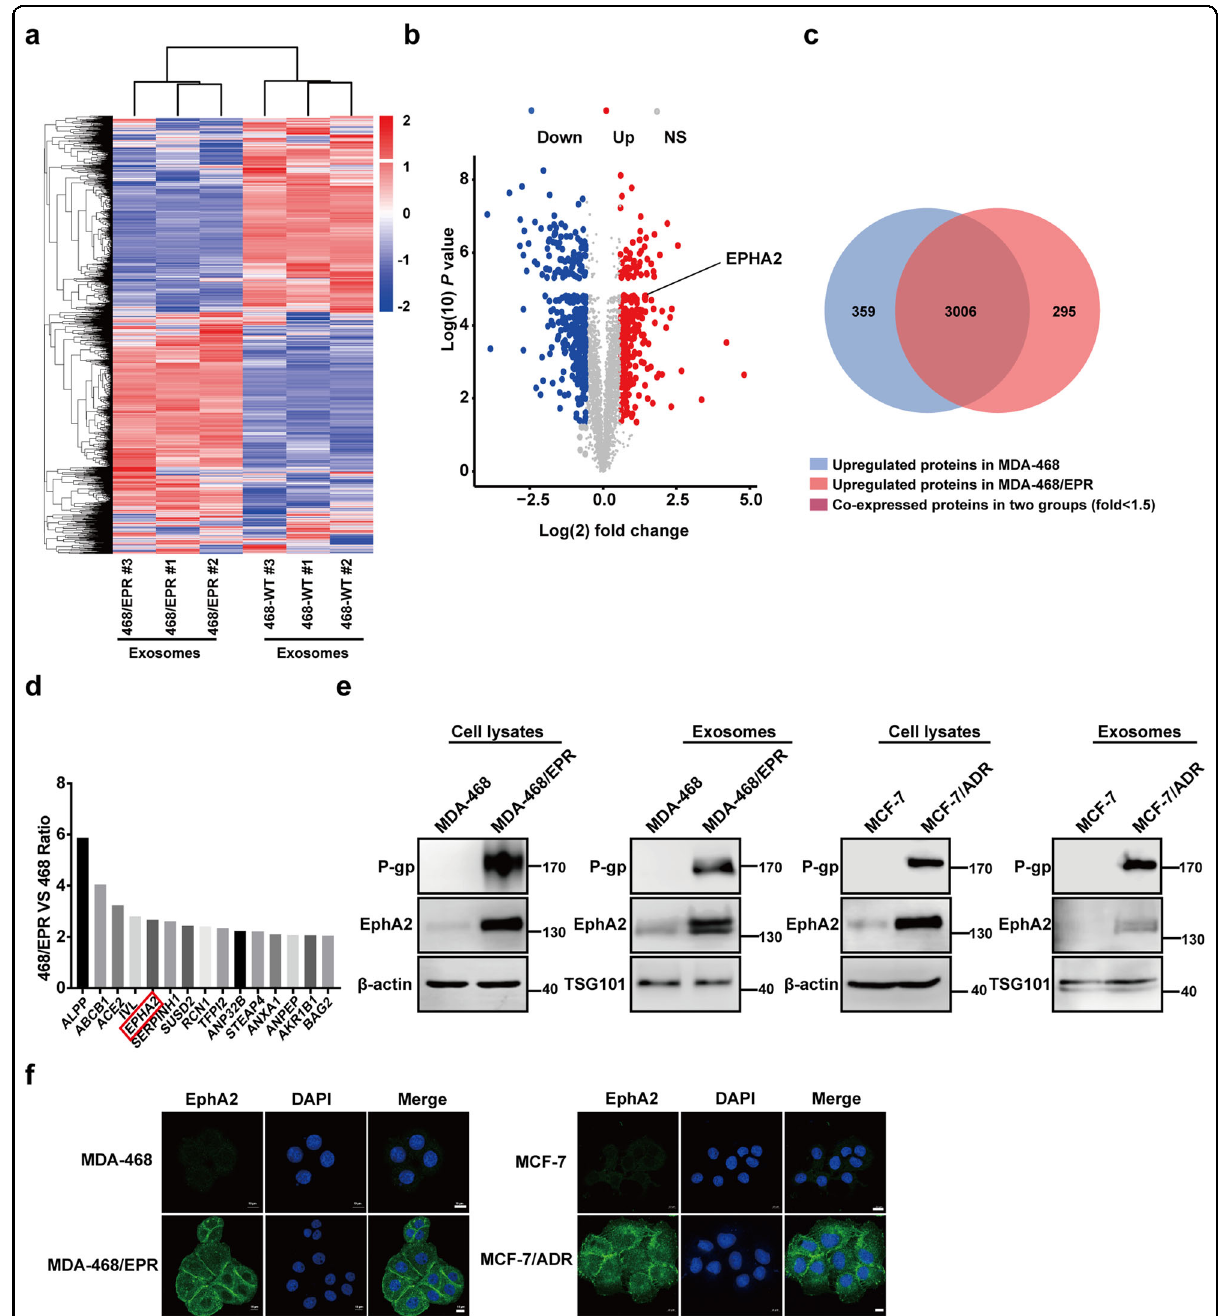
Fig. 2 EphA2 protein is enriched in exosomes derived from drug-resistant cells. a Heat map of exosomal proteins differentially expressed in MDA-MB-468 and MDA-MB-468/EPR cells. Exosomes were isolated from drug-resistant breast cancer cells and their parental cells, and then a TMT- based quantitative proteomic method was performed to identify differentially expressed proteins in two kinds of exosomes. b Volcano map of exosomal proteins differentially expressed in MDA-MB-468 and MDA-MB-468/EPR cells. Blue and red dots represent the proteins signi fi cantly upregulated in exosomes from MDA-MB-468 and MDA-MB-468/EPR cells. c The Venn diagram of different exosomal proteins in MDA-MB-468 cells and MDA-MB-468/EPR cells. d Fifteen proteins were identi fi ed by using a strict cutoff (fold change >2.00, score >100). e The expression of EphA2, ABCB1 (encode P-glycoprotein) in exosomes, and cell lysates were analyzed by using Western blotting; β -actin was used as the loading control. f The expression of EphA2 in two drug-resistant breast cancer cells and their parental cells was studied by using immuno fl uorescence staining. Scale bars: 10 μ m.